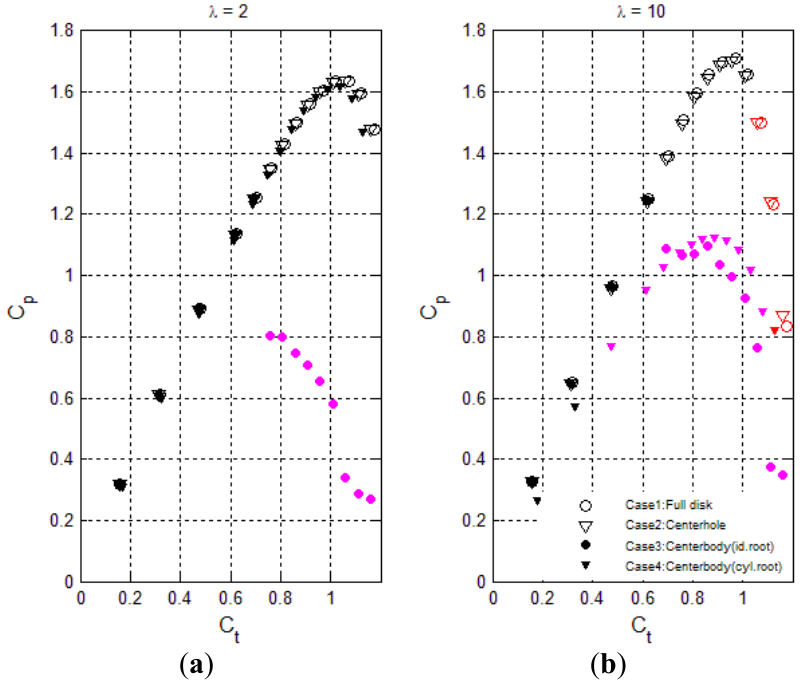
Figure 19. Rotor C T – C P performance plots for four multi-element DAWT nacelle/rotors.